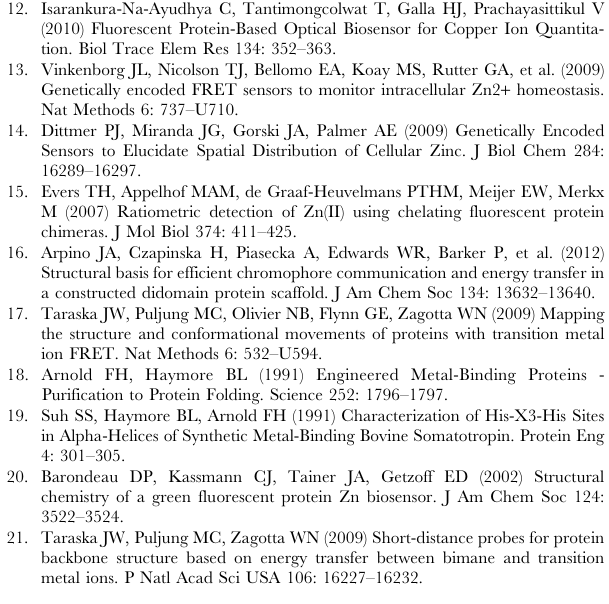
(TIF) Figure S5 Quenching curves for iq-mEmerald by copper ions without (black) or with the presence of physiolog- ical concentrations of calcium (1 mM, red) and magne- sium (10 mM, green) ions. Spectra are normalized to the fluorescence without metal and the relative fluorescence from each FP is plotted as a function of copper concentration. (TIF) Figure S6 Comparison between the emission spectra of FPs (top) and iq-FPs (bottom) used in this study. The spectra are nearly identical. The absorbance spectra of three color transition metal ions, Co 2 + , Cu 2 + , and Ni 2 + are plotted for reference. (TIF) Figure S7 (Top) Crystal contact interactions between two adjacent iq-mEmerald molecules. (Bottom) Zoom-in of the nickel-bound crystal structure. H202 and H204, along with D117 from the neighboring molecule, made direct connect with the nickel ion. H147 was not able to bind this nickel atom due to this crystal contact. (TIF) Figure S8 Overlay of the sedimentation coefficient distributions for 1 m M iq-mEmerald (black) and 1 m M iq-mEmerald with 10 m M Cu 2 + (red). The mass average s values for the monomer peaks in the Emerald c(s) are 4.15S and 4.27S, for the apo- and Cu-bound iq-mEmerald, respectively. The similar sedimentation coefficient distribution of iq-mEmerald indicates that metal ions do not dimerize iq-mEmerald. (TIF) Figure S9 Process used to generate the quenching curves in Figure 3. This example is the measurement of a ratiometric chimera construct, iq-mApple/mEmerald (middle panel on the first row of Figure 3). A and B are the normalized emission spectra from the contribution of iq-mApple and mEmerald of the chimear, respectively. The peak fluorescence of both underdifferent copper concentrations are taken and plotted as a fluorescent ratio of F iq-mApple /F mEmerald in C and reported in Figure 3. The excitation wavelengthes for this dimeric construct